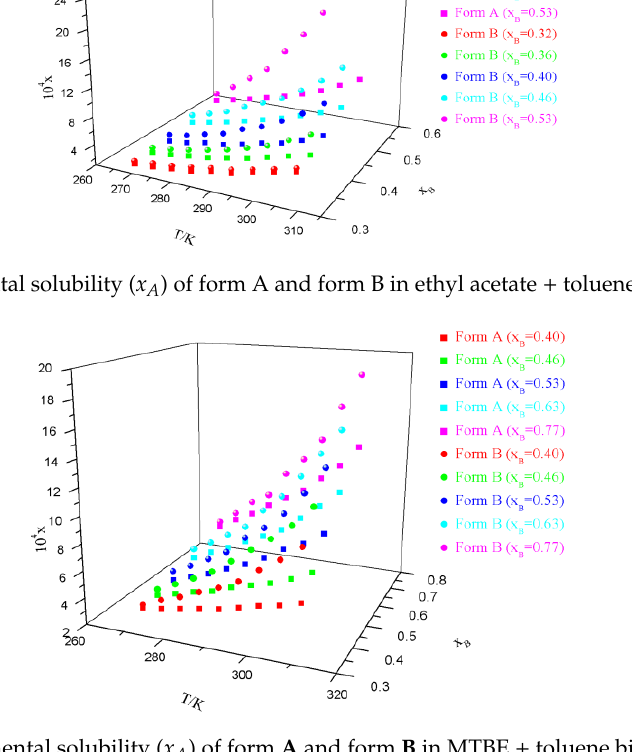
Figure 4. Experimental solubility ( x A ) of form A and form B in MTBE + toluene binary solvents.